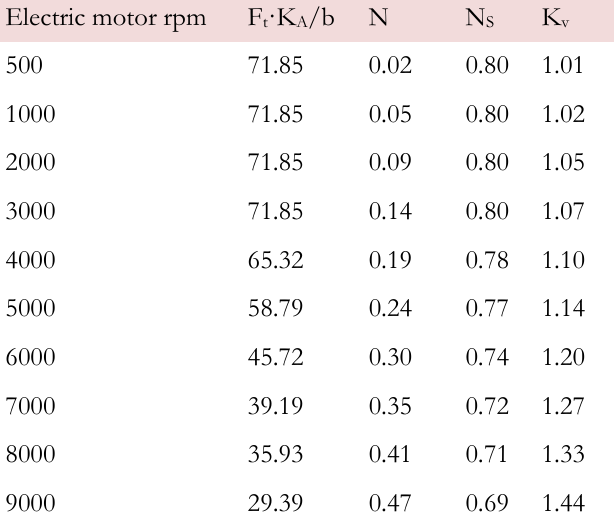
Table 2: K v values in function of the electric motor speed.